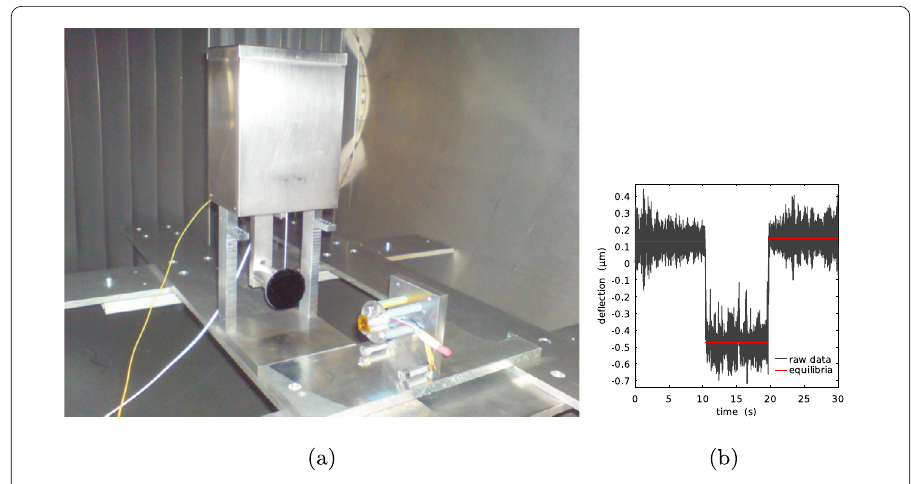
Figure 9 ( a ) View into the test chamber at the force probe (left) with the carbon fiber velvet measurement target (diameter 40 mm) and the FEEP thruster (right). Unlike the measurement configuration, the thruster was rotated by 90 degrees for better visibility. ( b ) Example measurement of the displacement. The thruster is firing for 10 s starting at t ≈ 10 s